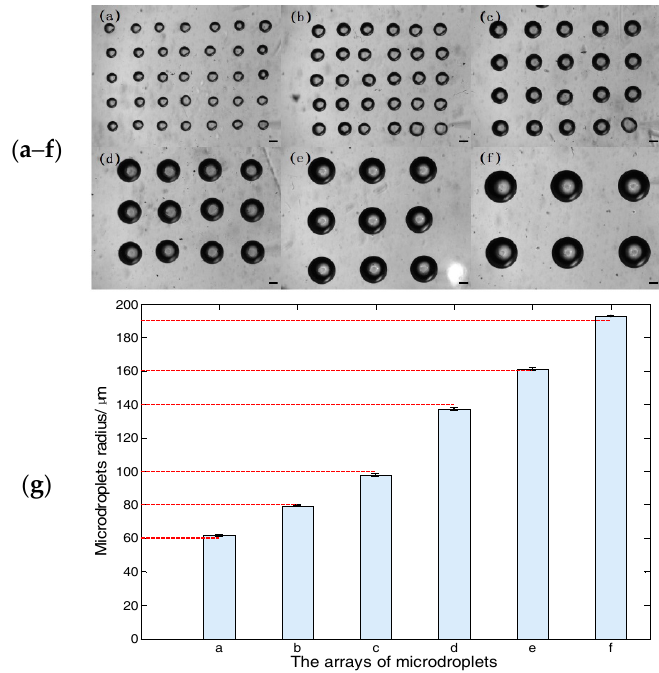
Figure 11. The experimental results and analysis. ( a – f ) The bright-field image of microdroplets, the scale bar is 100 μ m (see Supplementary Video S1); ( g ) the uniformity analysis of the microdroplets’ radii, the column denotes the radius mean and the dashed red lines are the desired radii. The error bars are standard errors, which are 0.83%, 0.56%, 0.7%, 0.64%, 0.63%, and 0,